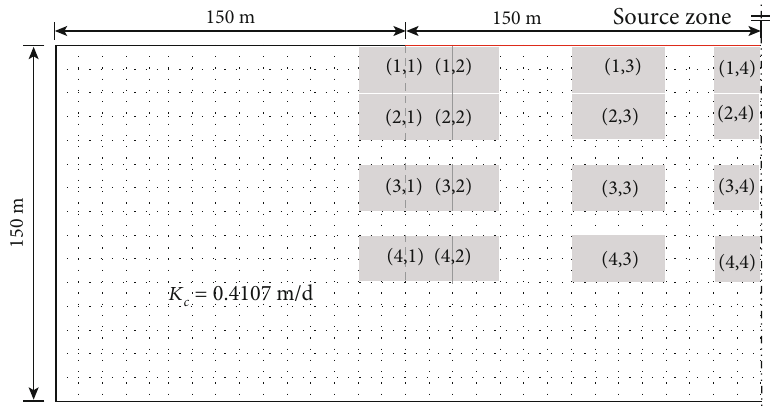
Figure 2: The selected locations to place the low-/high-permeability inclusion (the grey rectangles). The locations are labeled by their horizontal and vertical positions, e.g., the low-/high-permeability region is placed close to the source zone center at (1, 4) and far from the source zone at (1, 1). Note that the regions at the furthest locations ((1, 1), (2, 1), (3, 1), and (4, 1)) are partially out of the range of the source zone.